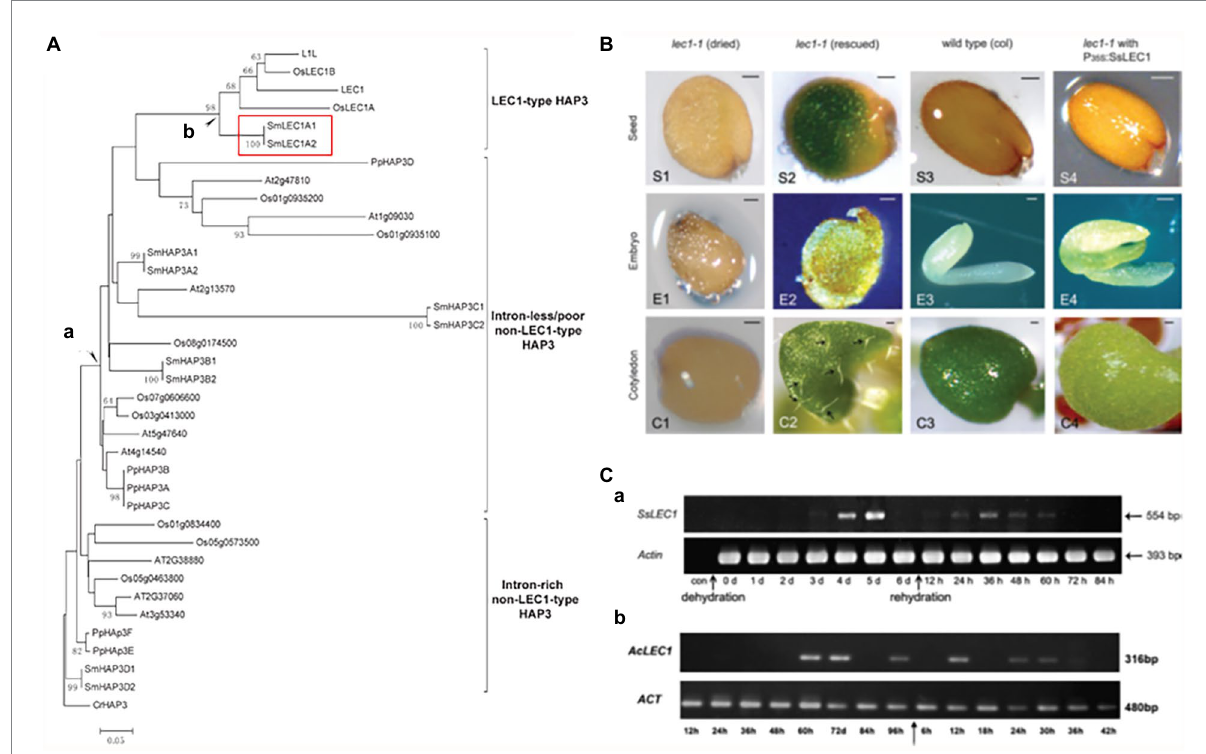
FIGURE 5 LEC1 -like gene sequence identification, functional complementation, and stress-inducible expression in lycophytes. (A) Phylogeny of HAP3 proteins from different plants, in which the LEC1-type HAP3 (LEC1-like) proteins were identified in the branch labeled “b” (the protein sequences with the prefix “Sm” are from Selaginella moellendorffii and are highlighted by a red rectangle). (B) SsLEC1 (LEC1-like from Seleginella sinensis ) can complement the lec1 mutant phenotype in Arabidopsis. (C) Drought-induced expression of the LEC1 -like genes in Selaginella sinensis (a) and Adiantum capillus-veneris (b; modified from Xie et al.,